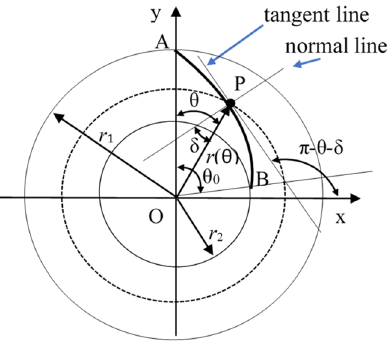
Figure 3. Geometric relationships of the transition curve. (Figure is drawn with the drawing tools of the Microsoft Word software and saved as a